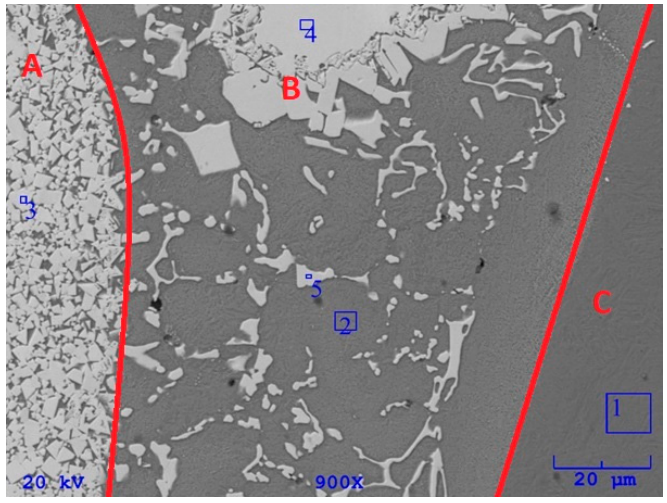
Figure 6. Tooth SEM image: 1—substrate (tooth base steel), 2—matrix of WC coating in transition zone, 3—WC, 4—WC in transition zone, 5—WC in transition zone, Zones: A—coating, B—transition zone (mixing zone), C—substrate (tooth body).